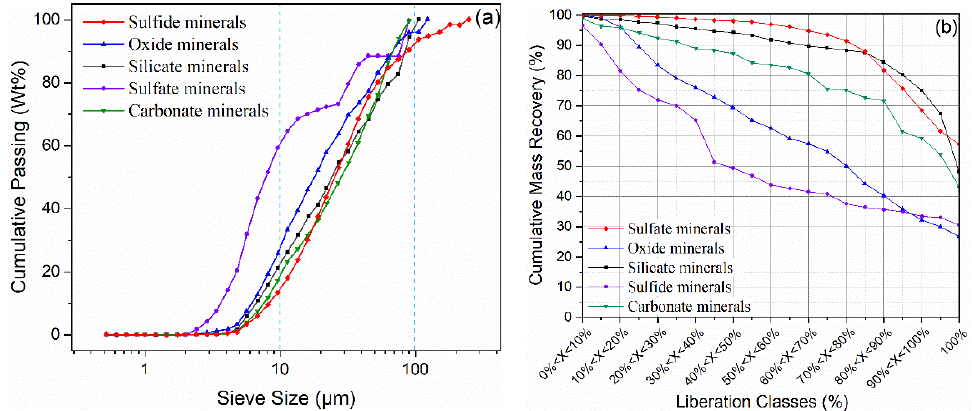
Figure 2. ( a ) Sieve size distribution for different minerals in sulfide concentrate; ( b ) liberation classes results for sulfide concentrate.